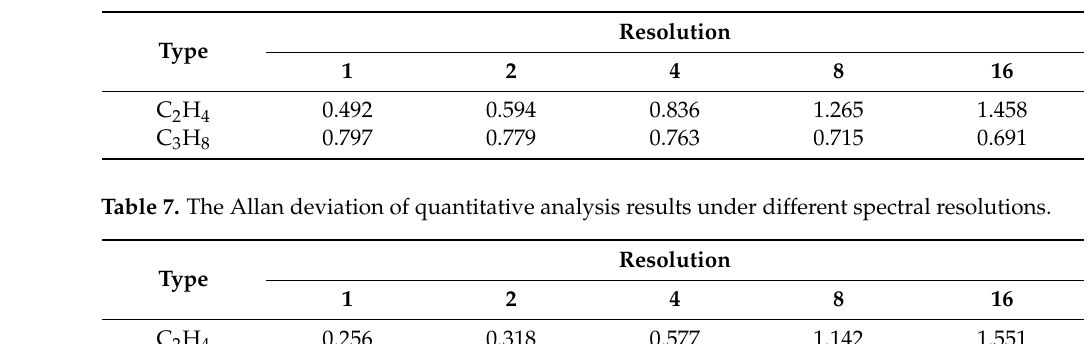
Table 6. The standard deviation of quantitative analysis results under different spectral resolutions.